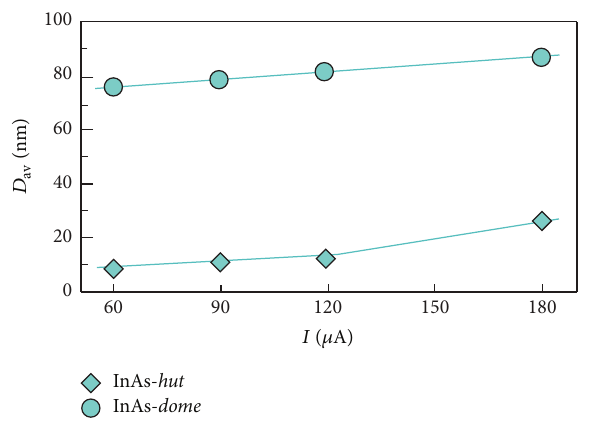
Figure 8: Average size of InAs nanoislands as a function of ion- beam current.